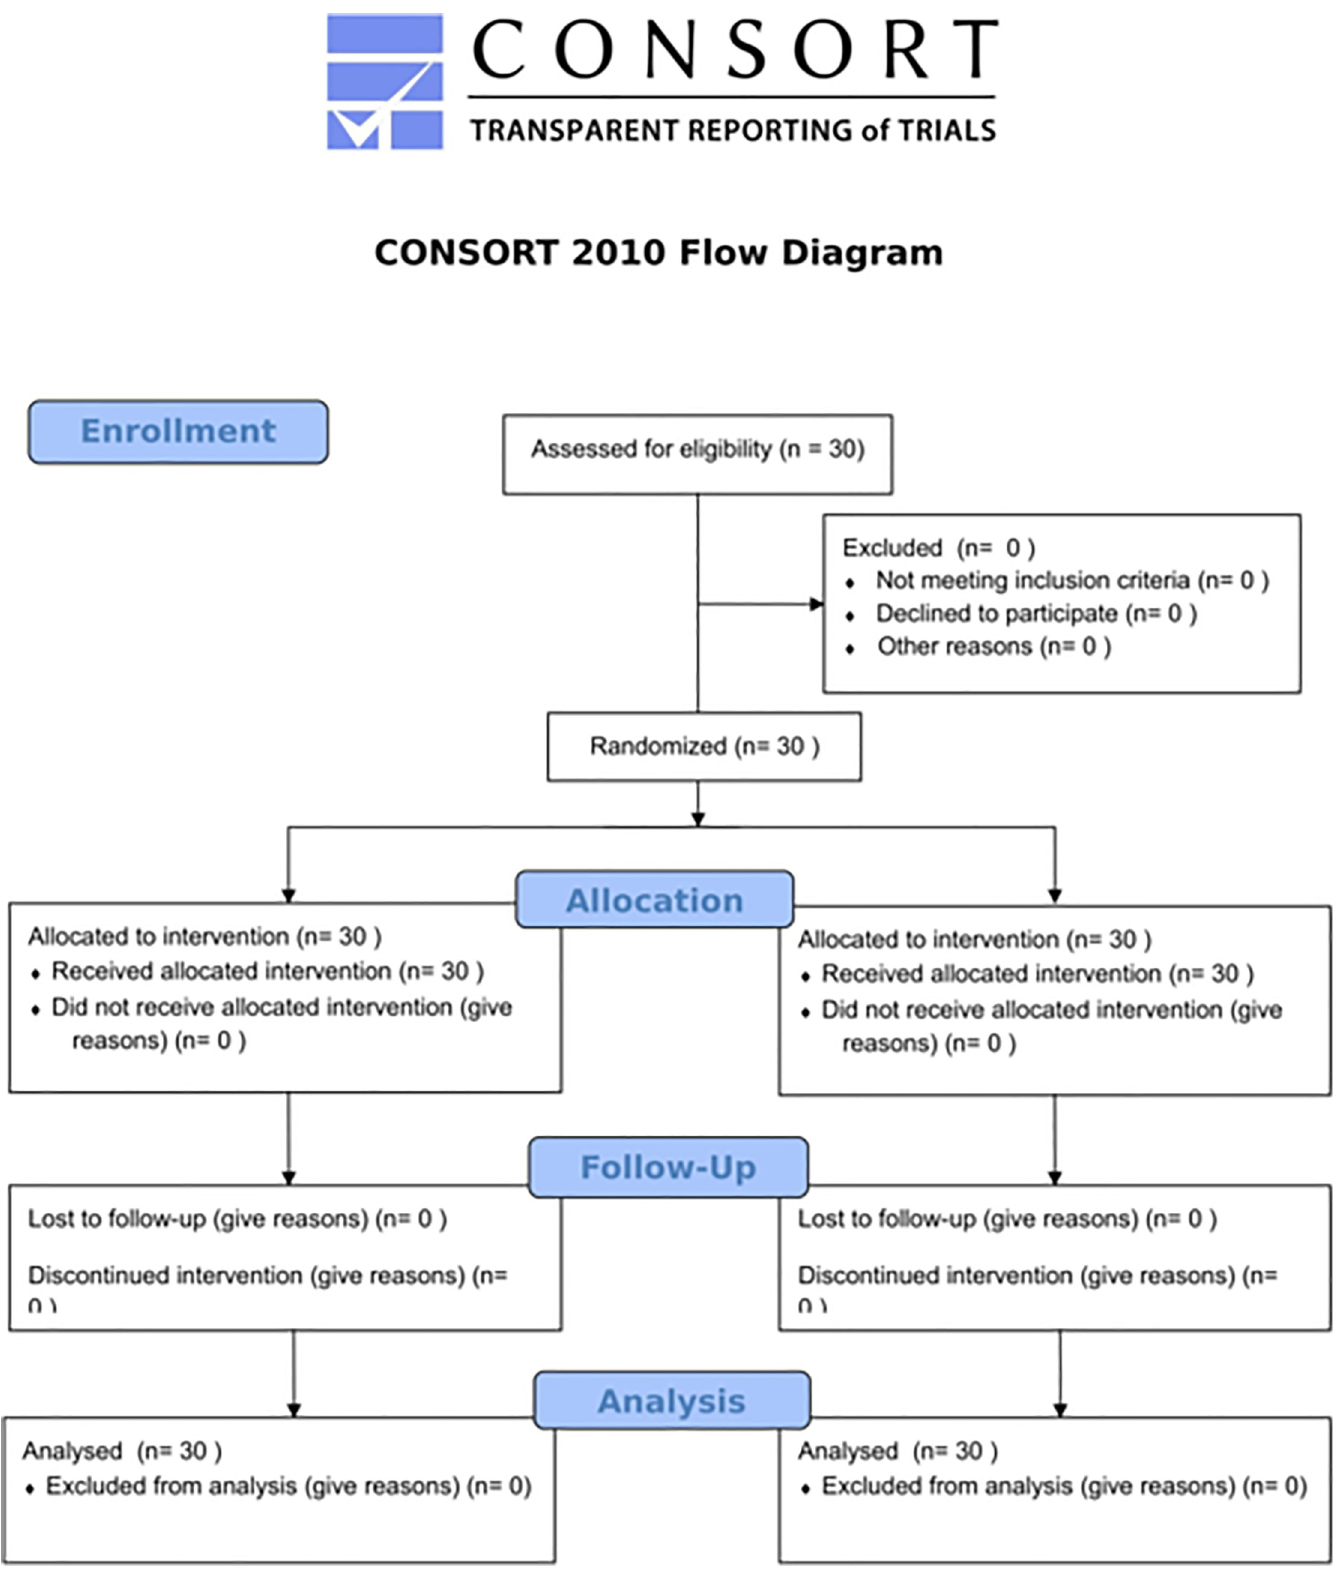
Fig 1. CONSORT flow diagram.